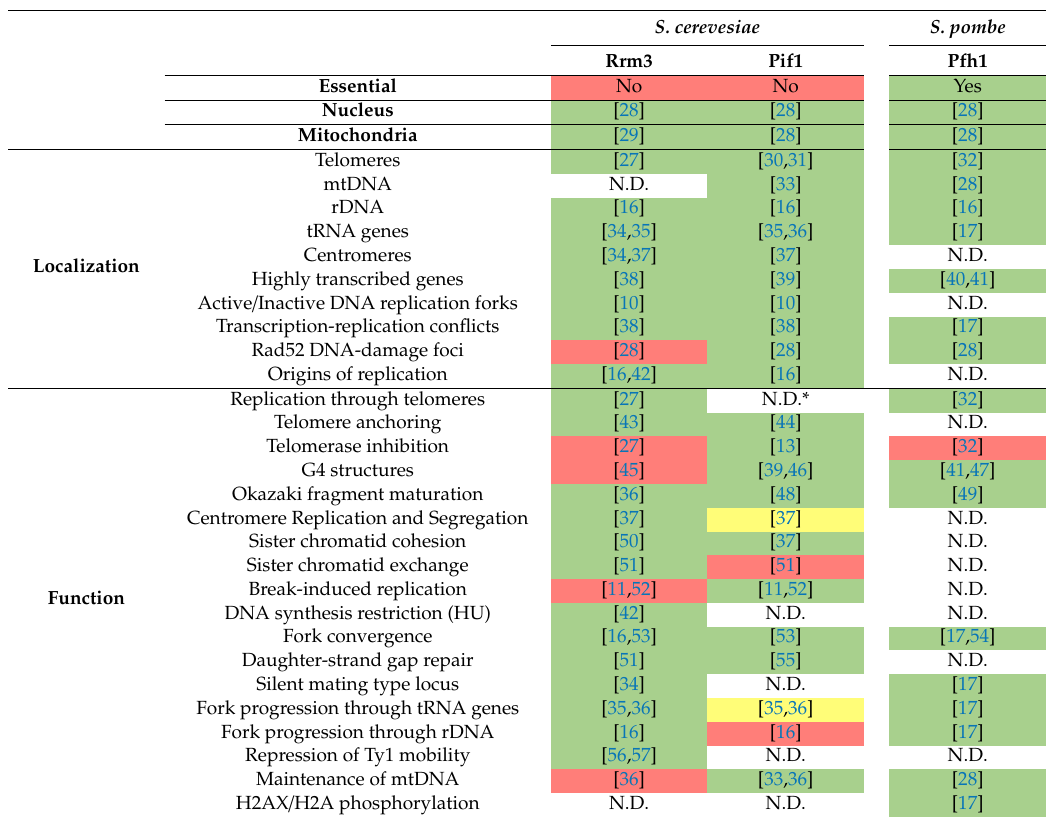
Table 1. Yeast PIF1 helicase function in the maintenance of genomic integrity. Rrm3 and ScPif1 localize mainly to the same genomic sites in the yeast genome and have several overlapping functions. Green boxes indicate the ability to perform the function, red boxes mark the absence of the function, and yellow indicates a backup role. Pfh1 localizes to similar sites as ScPif1 and Rrm3, but several functions and associations with genomic loci known for Rrm3 and ScPif1 have not been tested for Pfh1. *Pif1 was not found to a ff ect replication through telomeres when assayed by 2D gels [27], but the more recently discovered role of Pif1 in G4 unwinding might suggest such a role. Numbers indicate references to relevant studies. N.D. indicates not